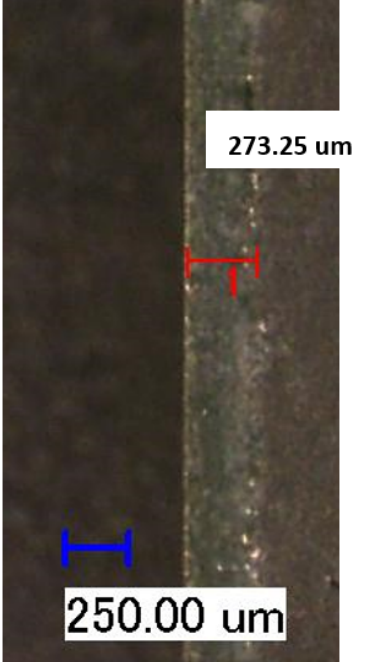
Figure 17. The simulated and measured crater wear for dry and flood-coolant modes.